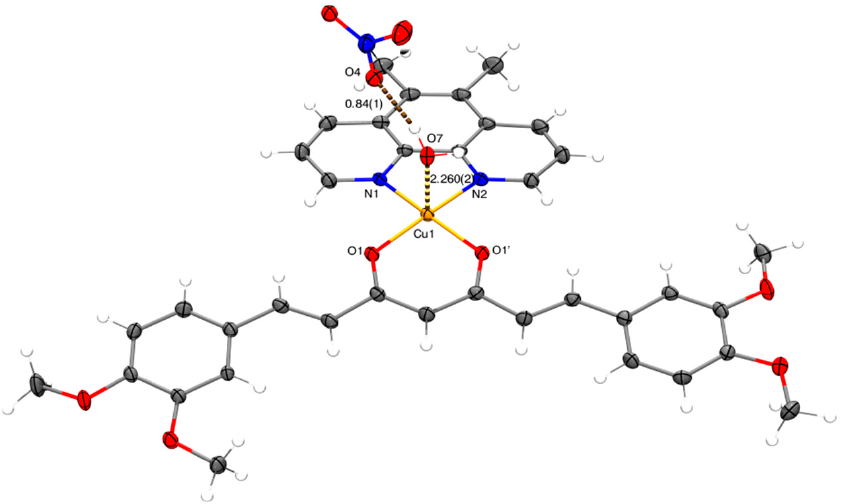
Figure 10. Molecular structure of complex D6CuL2 with displacement ellipsoids at 50% probability level. Table 4. Selected bond lengths (Å) and angles (°) for compounds D5CuL2 and D6CuL2.